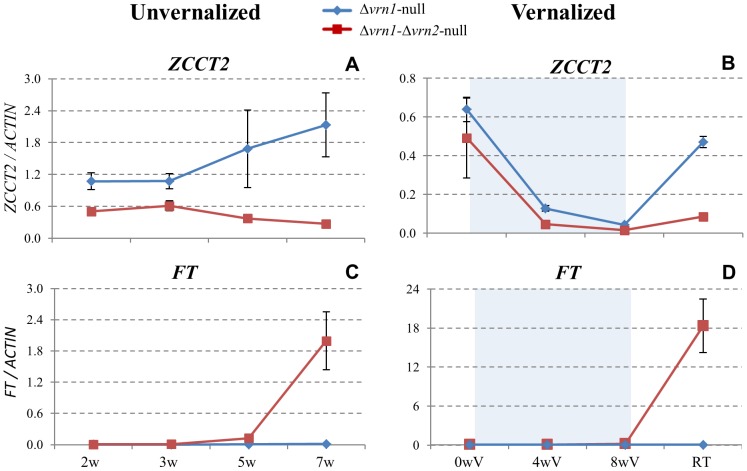
Comparison of VRN2 and FT transcript levels between Δvrn1-null and Δvrn1-Δvrn2-null mutants.A–B) ZCCT2, C–D) FT. Left panels A and C) unvernalized plants. Right panels B and D) vernalized plants. Δvrn1-null: no functional VRN1 proteins (functional VRN2, winter), Δvrn1-Δvrn2-null: truncated VRN1 and VRN2 proteins (early). Blue shaded areas indicate vernalization at 4°C under long days. 0 wV: 3 weeks-old plants grown under 22°C/17°C (day/night) conditions before vernalization, 4 wV: 4 weeks of vernalization, 8 wV: 8 weeks of vernalization, RT: two weeks after returning the vernalized plants to pre-vernalization conditions. A–B) ZCCT2 ( = VRN2). Lower transcript levels in the Δvrn1-Δvrn2-null mutant (red line) are likely caused by the complete deletion of the VRN-B2 genes in this line. Only the non-functional ZCCT-A2 transcripts are detected, C–D = FT. Note the rapid up-regulation of FT in the Δvrn1-Δvrn2-null mutants relative to the Δvrn1-null mutants. The X axis scale is in weeks (w) and is not proportional to time. The Y scale is in fold-ACTIN values. Error bars are SE of the means from 8 biological replications.